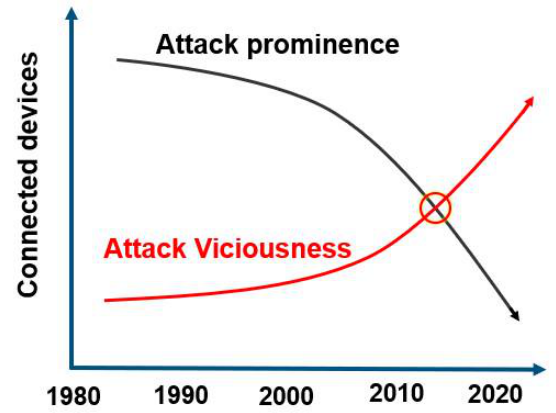
Figure 2. The growth and nature of attacks over the years Figure 2 . The growth and nature of attacks over the years [33].